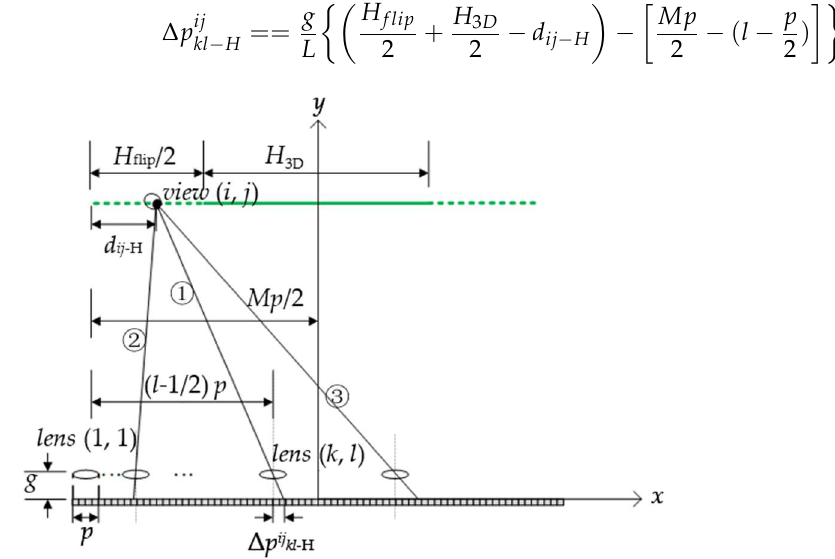
Figure 4. Correspondence between view ( i , j ) and the pixels displayed on the screen. Equations (6) and (7) apply to cases where lens ( k, l ) is located on the right (case ○ 1 ) and left (case ○ 2 ) side of view ( i , j ), as well as that lens ( k, l ) lies to the left (case ○ 1 ) and right (case ○ 3 ) side of the central symmetrical axis of the system. According to the calcu- lated values of the horizontal and vertical deviations, the traced pixel shifts to the left for Δ p ijkl- H < 0 and to the right for Δ p ijkl- H > 0. Similarly, it moves up when Δ p ijkl- V > 0 and down when Δ p ijkl- V < 0.